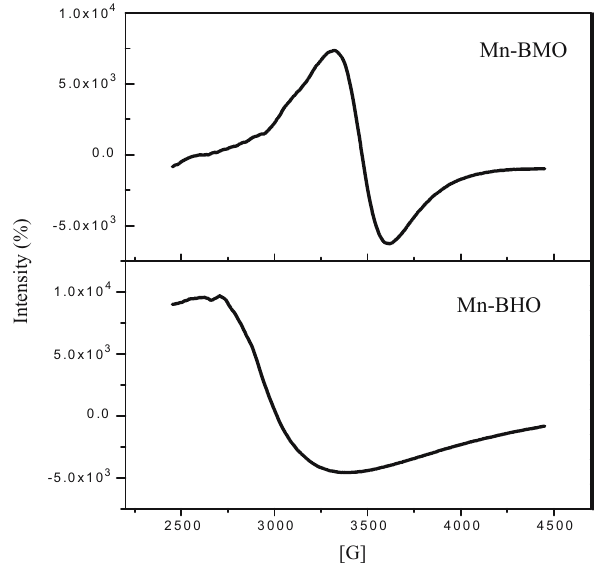
Figure 4: EPR spectra of solid manganese ( II ) complexes